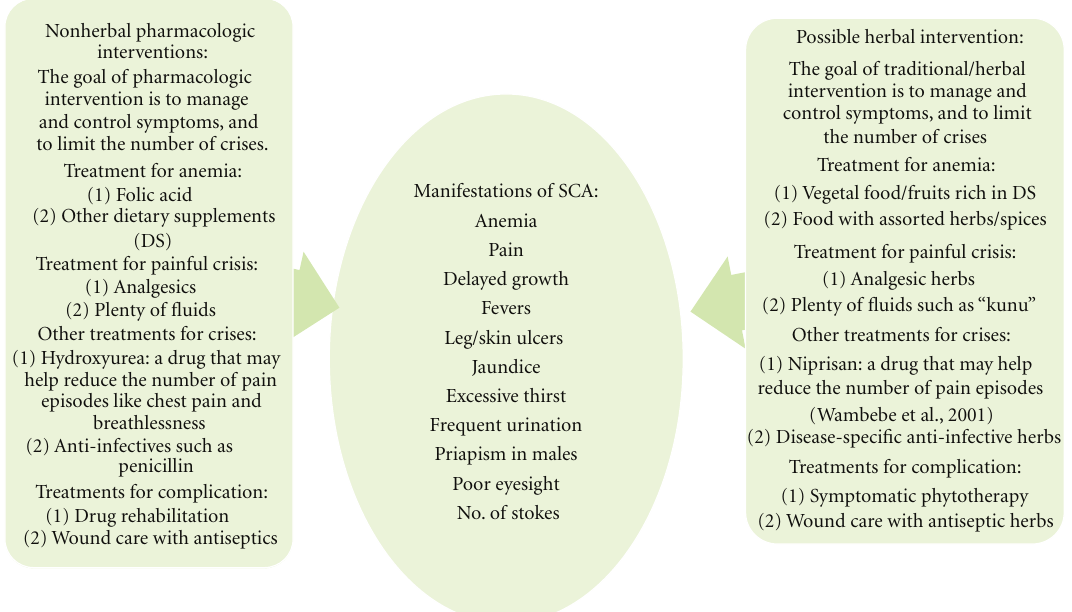
Figure 1: Manifestations of SCA and strategies for management including herbal treatment. The two major pathologies of SCA are hemolytic anemia and vasoocclusion with pain especially in the limbs. Acute chest syndrome, which can result from infections, is the leading cause of death. Neurologic complications such as stroke and hemorrhage can occur. Aplastic crisis is most often the result of infection with Parvovirus B19, which results from temporary cessation of RBC production. Genitourinary-hematuria, renal failure, and priapism may occur. Cholelithiasis due to severe hemolysis can develop into acute cholecystitis due to the formation of pigmented gallstones